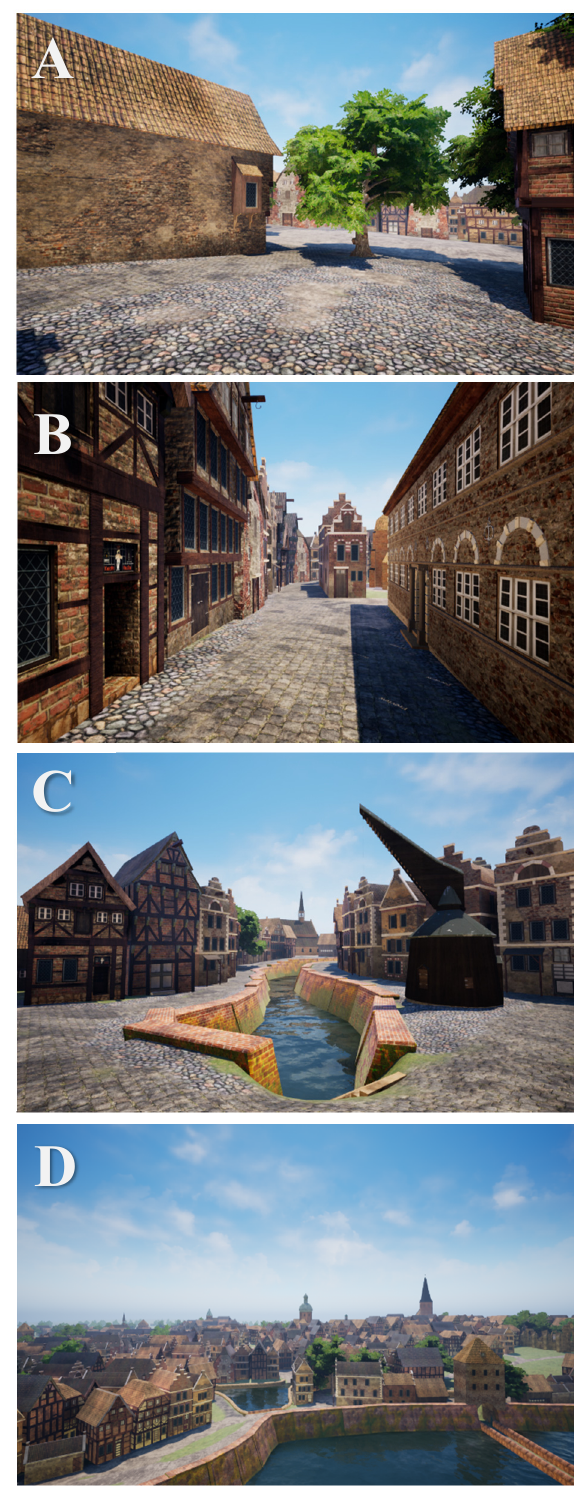
Figure 8. Screenshots showing the current state of the virtual environment, as of writing. (A) Looking onto the Pferde- marktplatz; (B) View down the Hökerstraße with town hall on right; (C) The Stade harbour; (D) City